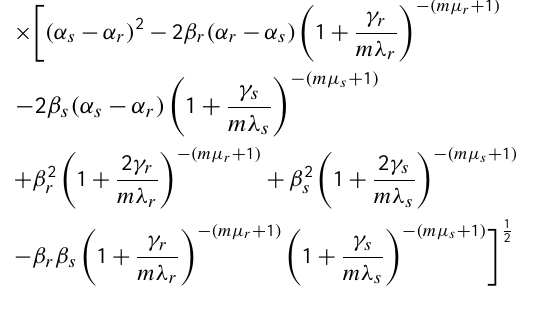
Fig. 6. Normalized mass collision rate for snow and rain using different approximations (dashed) compared to a numerical solution of the collision integral (solid) as a function of the raindrop mean volume diameter for different mean volume diameters of the snow size distribution.